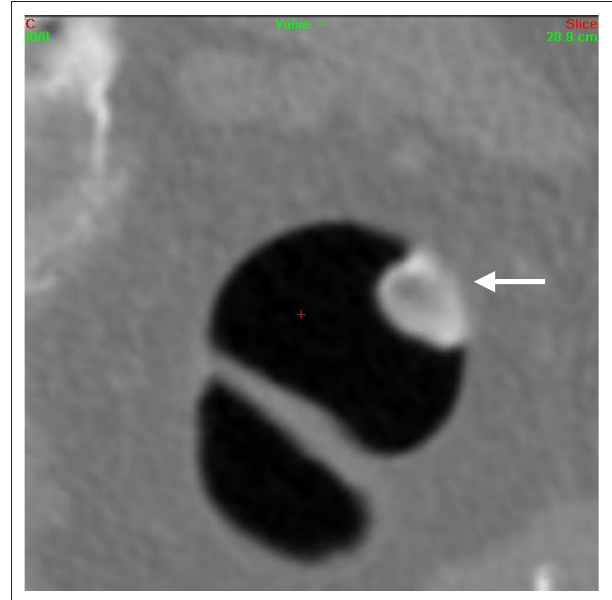
FIGURE 9: Stool moved to the opposite wall in the prone position.